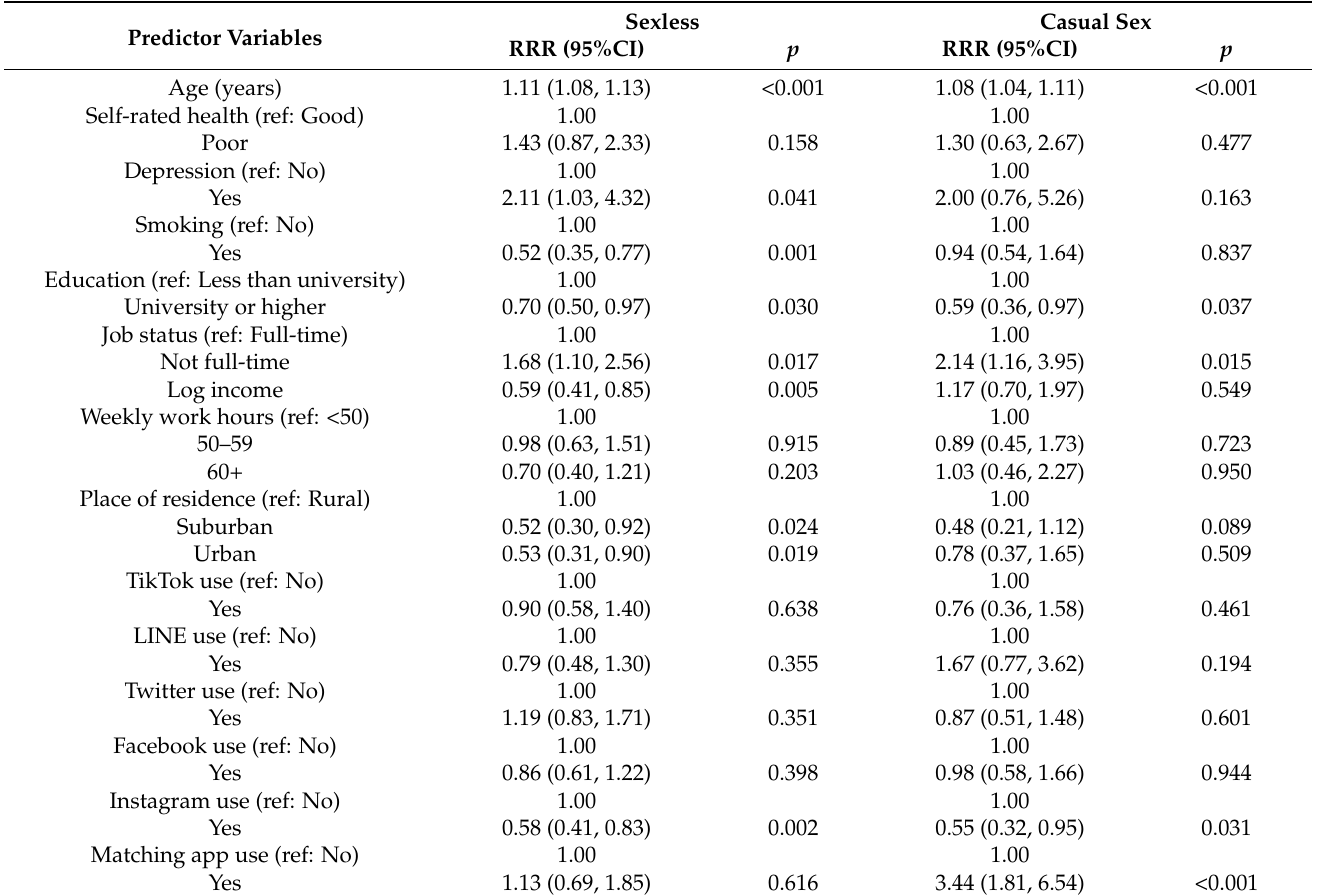
Table 5. Predictors of sex for never-married men in a multivariate multinomial logistic regression model ( n =